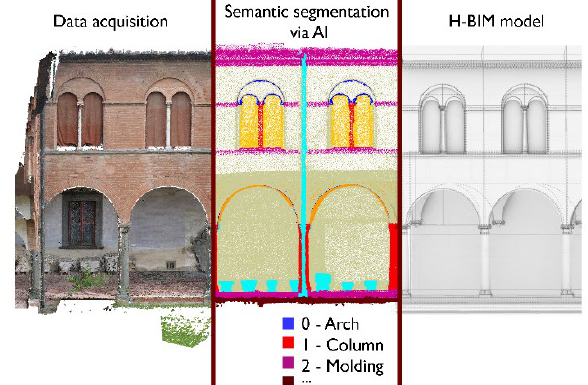
Figure 1. The steps of the proposed methodology illustrated for the main cloister of the Museo di San Matteo